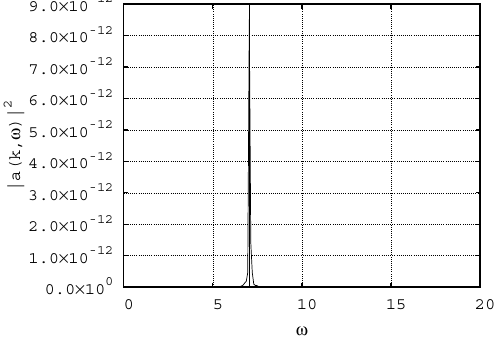
Figure 3. Spectral line of the harmonic k = (0, 50). Both the con- densate and inverse cascade were suppressed.